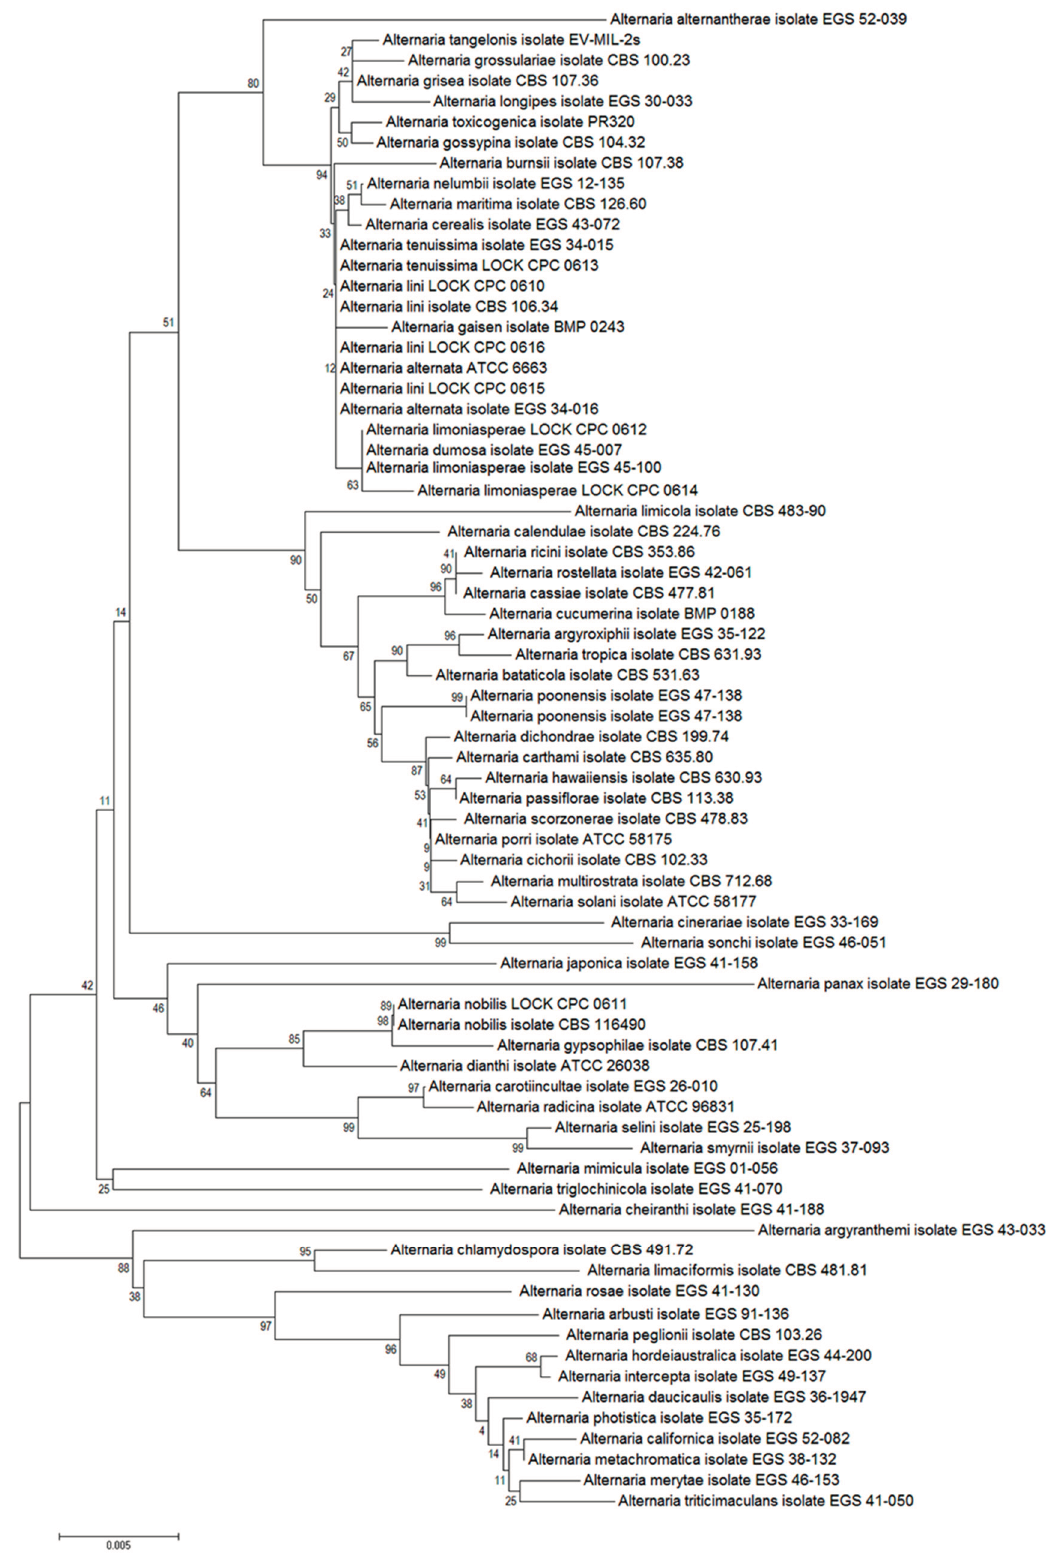
Figure 1. The phylogenetic tree constructed on the basis of actin gene sequences of reference and tested Alternaria strains. The tree was constructed using the Neighbor-Joining method and tested by bootstrapping (1000